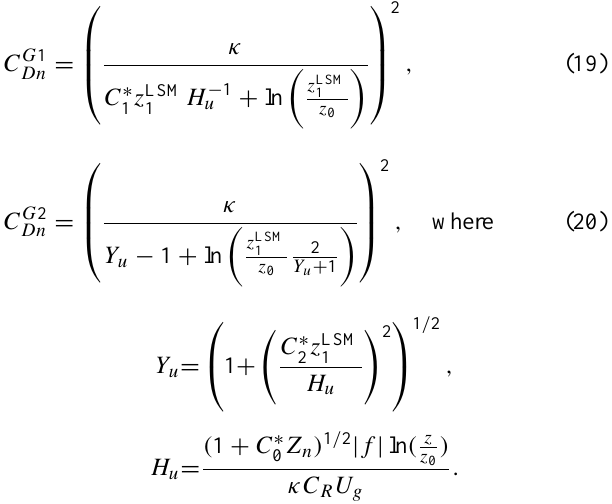
Fig. 8. The dependence of C LES is given by Eq. (18). Symbols and lines are the same as in Fig. 5.